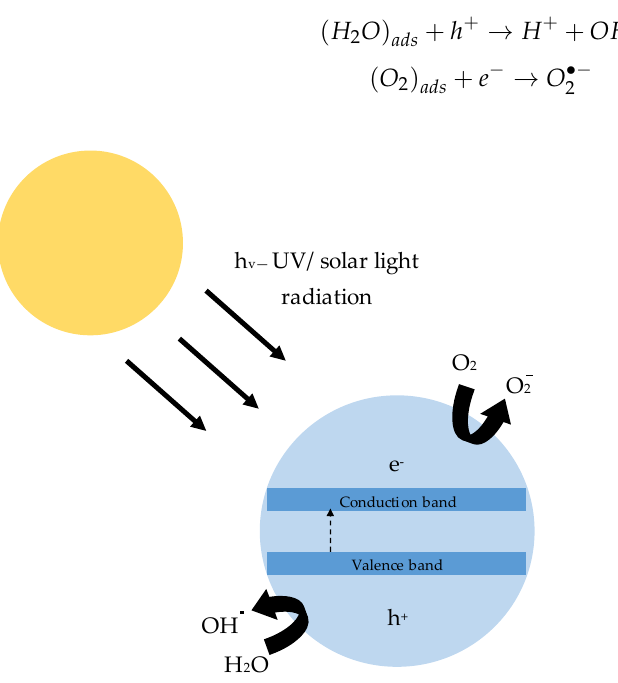
Figure 1. General mechanism of the photocatalytic reaction.